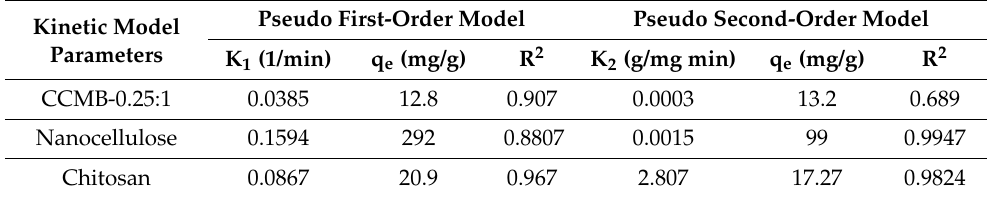
Table 4. Kinetic models